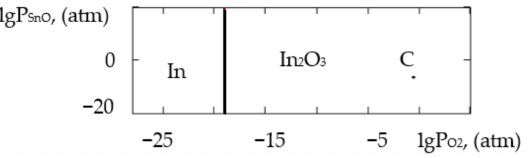
Figure 8. PPD in In–Sn–O system at temperature T = 1073 K within lgP O2 –lgP SnO . The calculations of the pressures of the saturated SnO and In vapours are shown in Table 6. The vapours of SnO and In in the Sn–Si–O, In–Si–O and In–Sn–O systems were only present in the gas phase at partial pressures lower than those in Table 6; if those pressures were reached, the gaseous components would condense. From the PPD in the Sn–Si–In–O system, it followed that under the conditions of the experiment (at the atmospheric